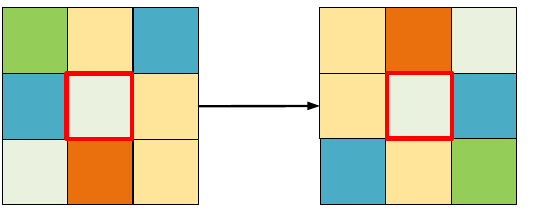
Figure 7. Gravity flip—rotate the 3 × 3 windows 180 degrees clockwise if it enhances modified GDP.